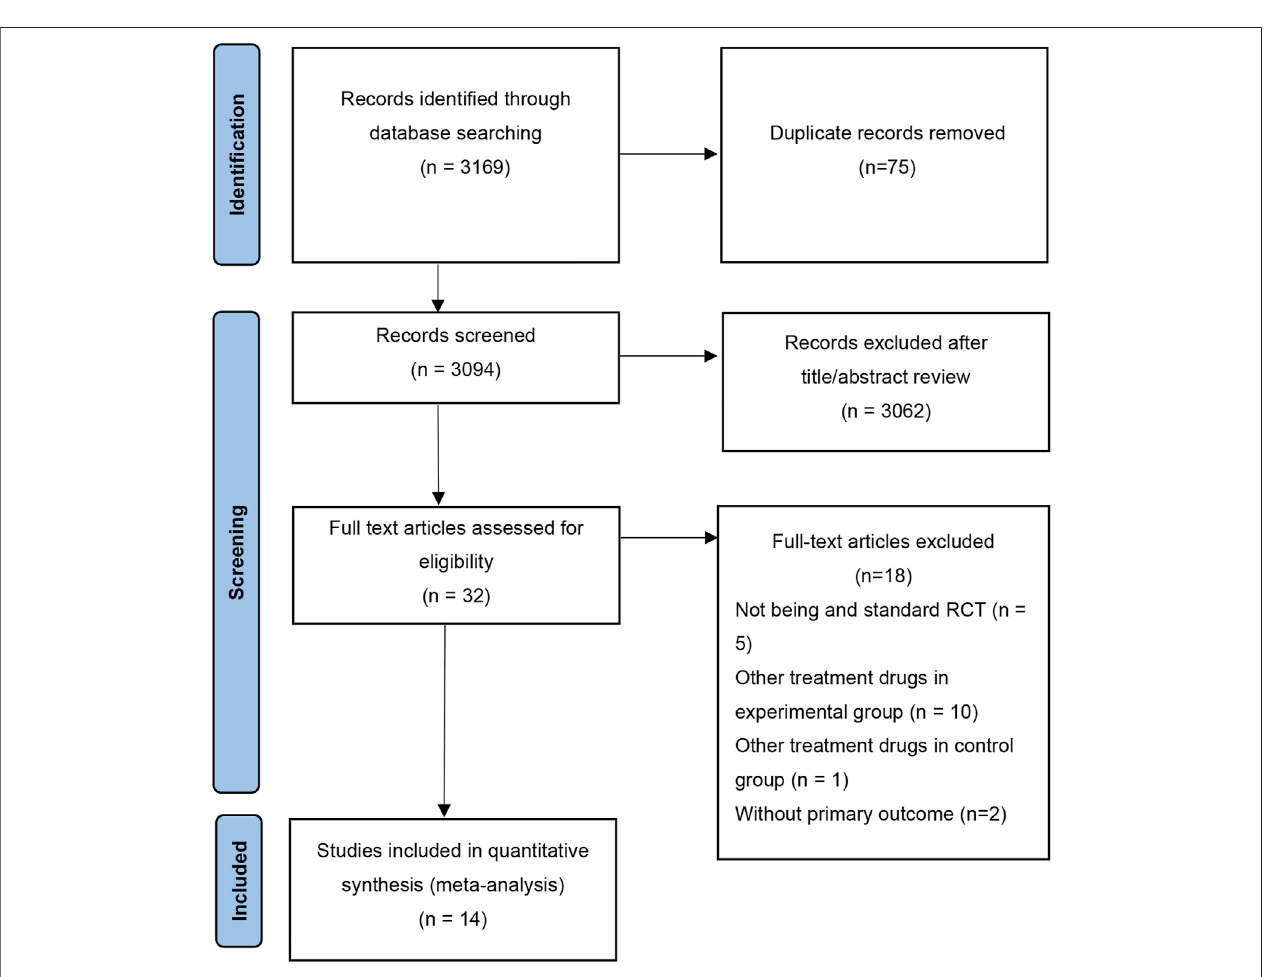
FIGURE 1 | The fl ow of original literature